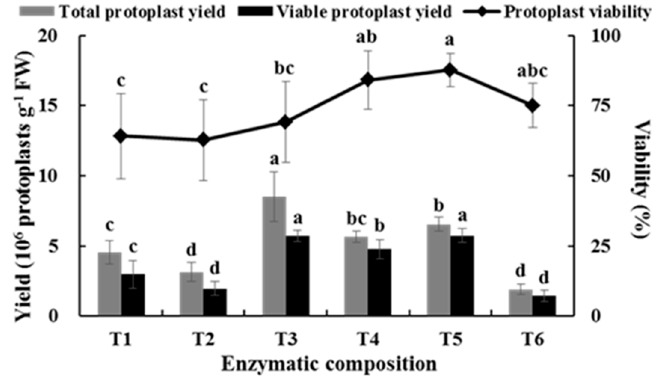
Figure 1. Effects of enzyme composition on the total yield and viability of Chinese kale hypocotyl protoplasts. Different letters represent a significant difference at p ≤ 0.05, and bars represent standard errors (SEs) (same as below). T1: 1.0% cellulose + 0.3% pectolase; T2: 1.0% cellulose + 0.5% pectolase; T3: 1.0% cellulose + 0.7% pectolase; T4: 3.0% cellulose + 0.3% pectolase; T5: 3% cellulose + 0.5% pectolase; T6: 3% cellulose + 0.7% pectolase.